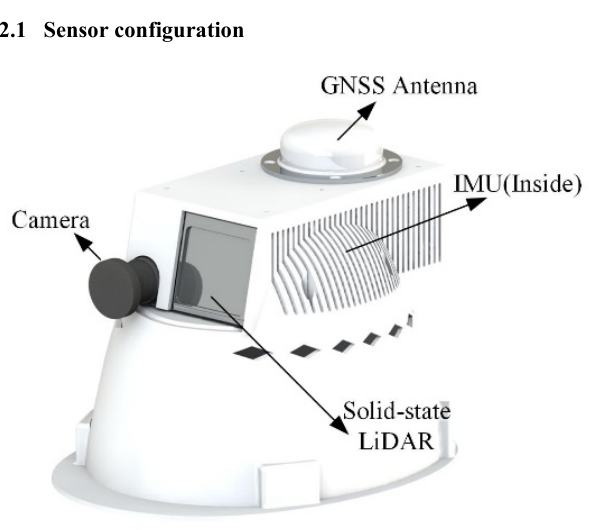
Figure 1. Hardware configuration of the helmet-based laser scanning system, WHU-Helmet.